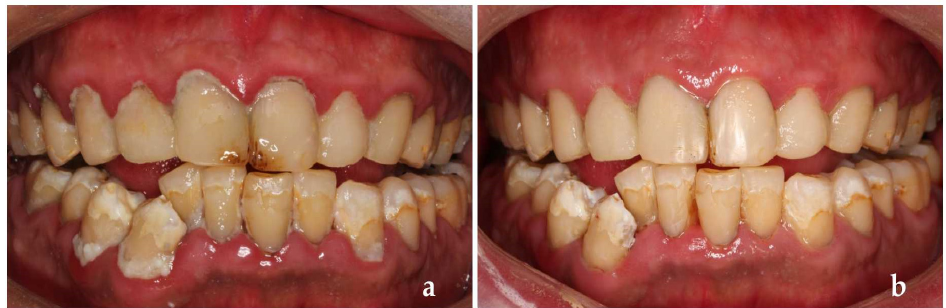
Figure 8. ( a ) Five years after treatment; ( b ) Retreatment completed.